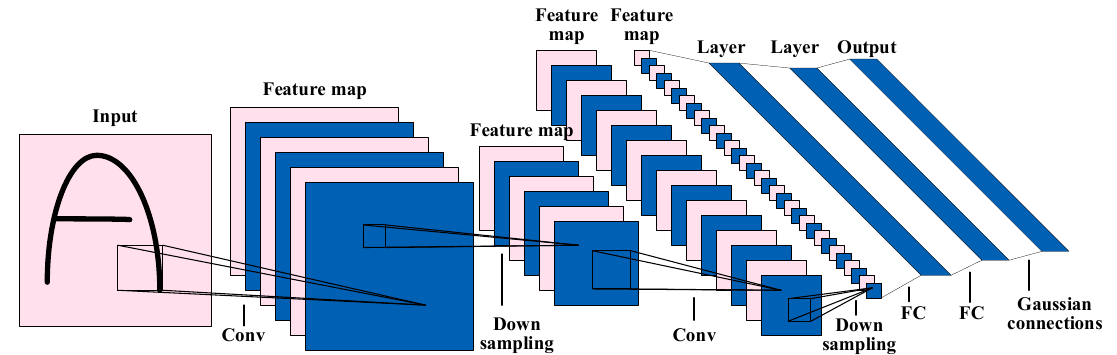
Figure 15. The network structure of LeNet.